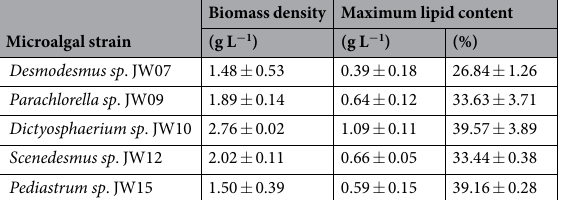
includes Desmodesmus sp. was not selectively enriched following temperature control, in spite of being favoured under the influent wastewater and meteorological conditions (Figs 3 and 5). Likewise, Pediastrum sp. was favoured at low temperature in the winter months 11, 12 , but temperature control allowed Chlorellaceae to domi- nate leaving the HRAP vulnerable to possible predation and environmental fluctuations (Figs 2 and 6). However, Pediastrum sp. was still able to grow which highlights that influent microbial diversity and other environmental